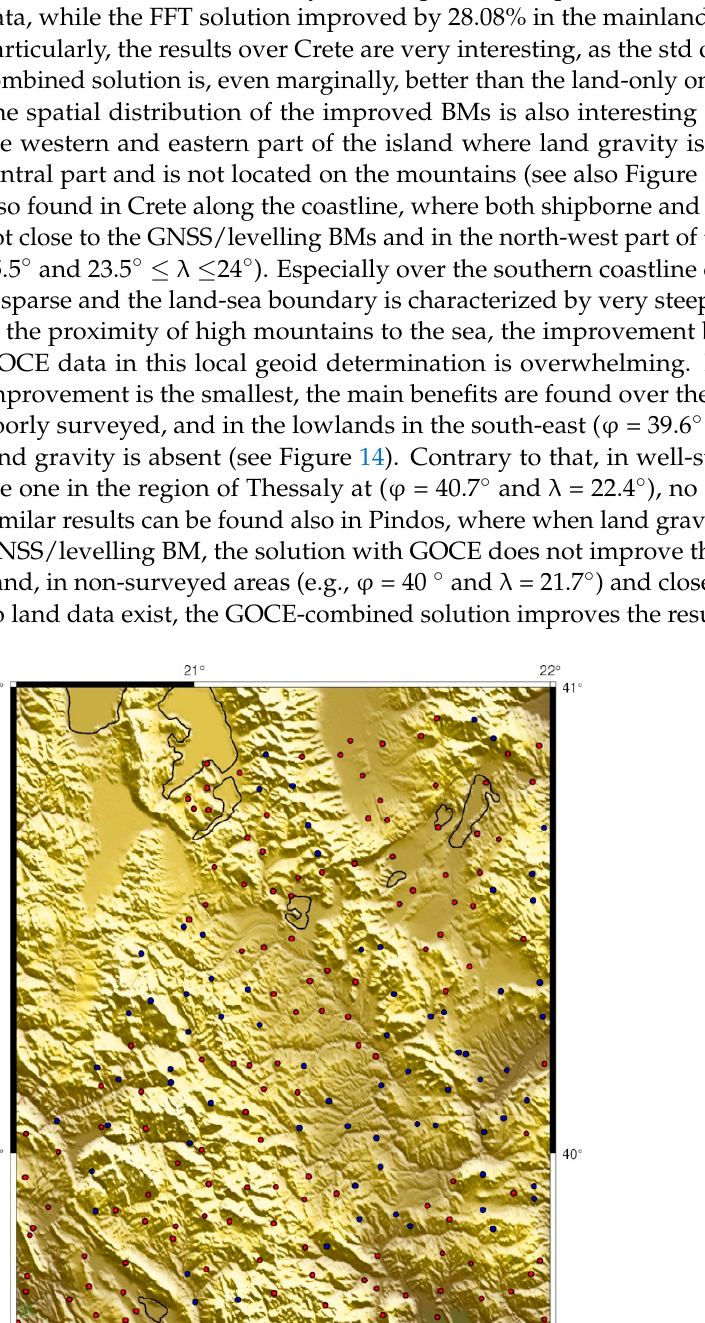
Table 9. Statistics of geoid height differences between the GNSS/leveling data and the LSC models with number of BMs with improved differences compared to terrestrial gravity only model. Unit: (m) .